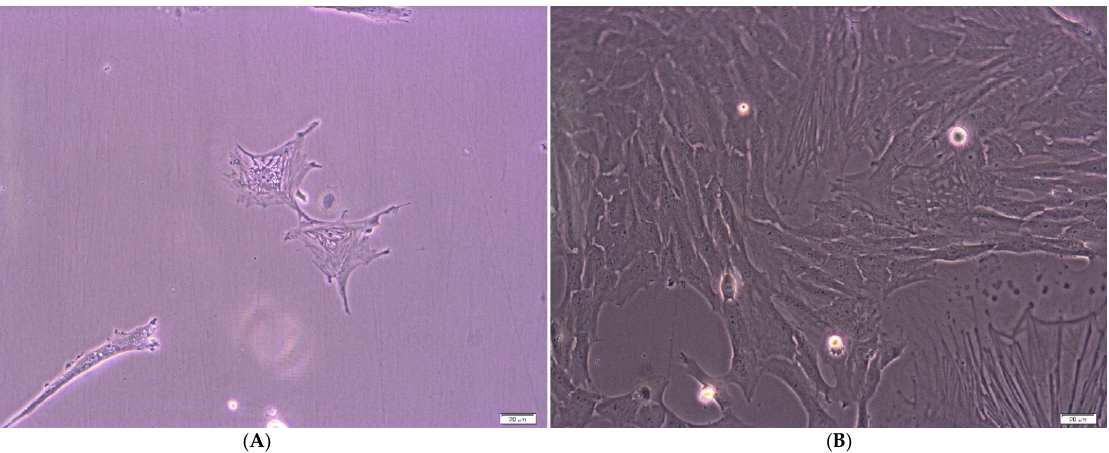
Figure 3. ( A ). Stem cells from a 4-day culture ( B ). Stem cells from a 10-day culture; bright field mi- croscopy (BF), 100× magnification (Xcellence RT system with an IX81 inverted microscope Olym- pus). croscopy (BF), 100 × magnification (Xcellence RT system with an IX81 inverted microscope